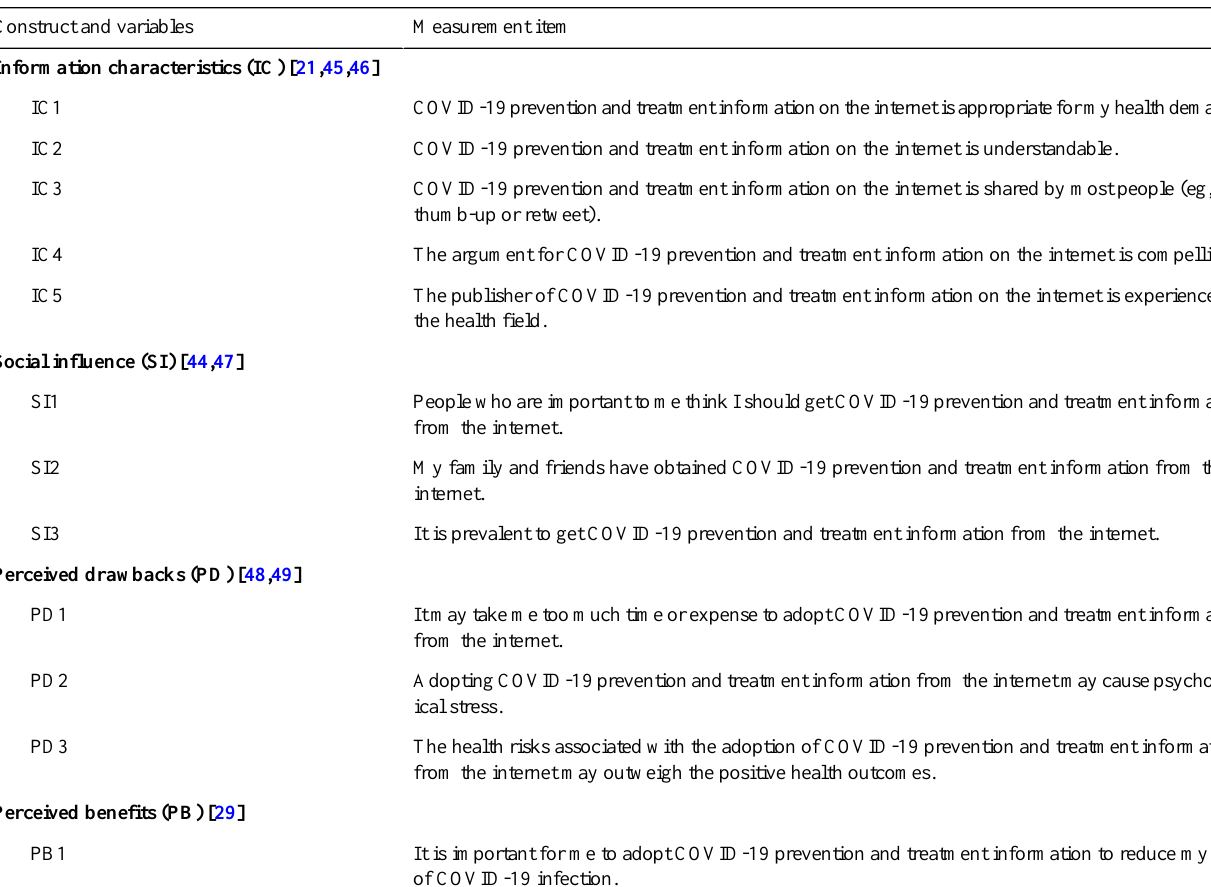
Table 2. Measurement items of the constructs.